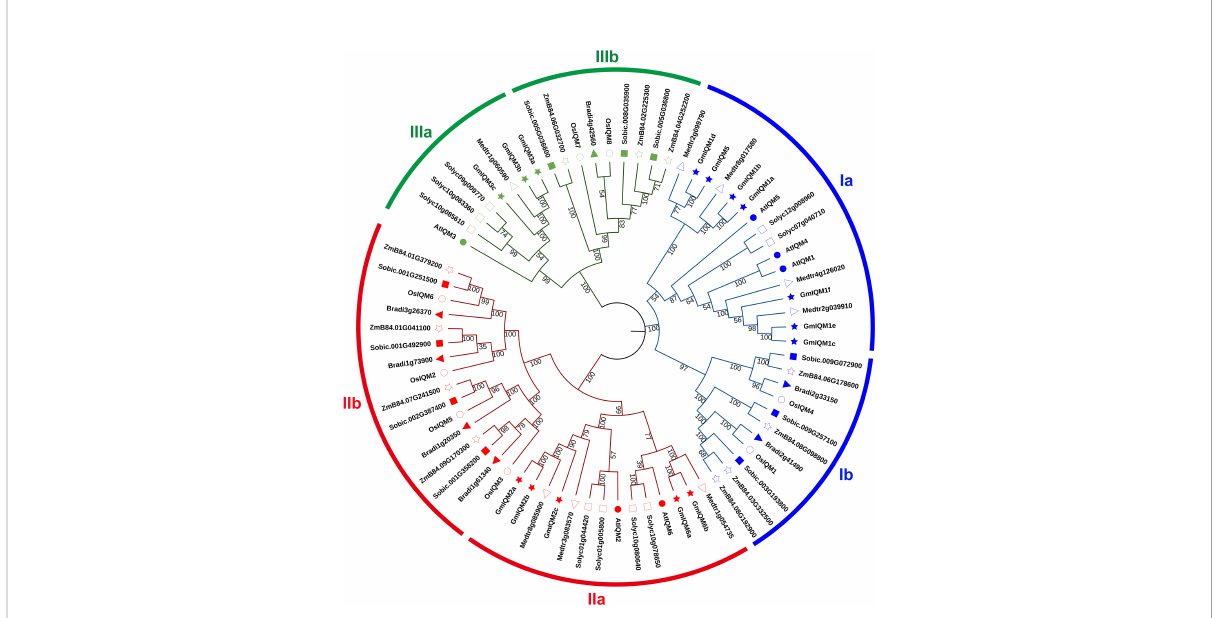
FIGURE 5 Phylogenetic relationships of IQMs in eight species.The full-length amino acid sequences of 74 IQMs were aligned using ClustalW, and the unrooted phylogenetic tree was constructed using MEGA11 by the neighbor-joining method. The number of bootstrap values was 1000 replicates. At, Arabidopsis; Gm, soybean; Medtr, alfalfa; Solyc, tomato; Os, rice; ZmB84, maize; Sobic, sorghum; Bradi, Brachypodium distachyon . Blue, subfamily I; red, subfamily II; green, subfamily III. The shapes preceding the gene numbers represent different